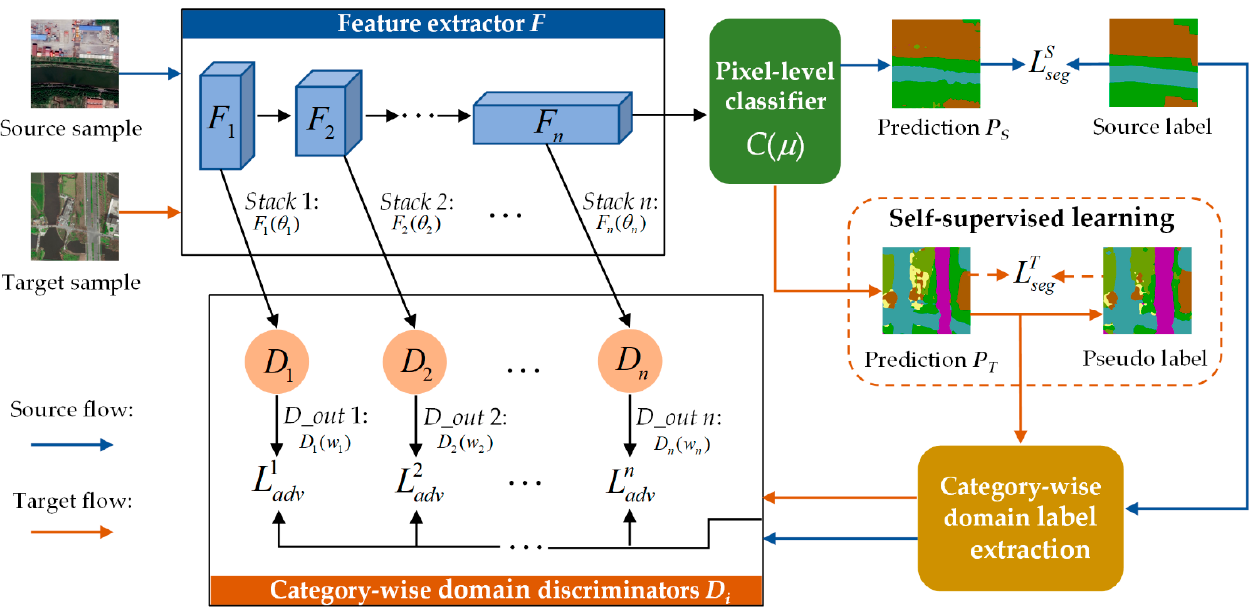
Figure 2. An overview of the proposed category-space constrained adversarial network for cross-domain coastal land cover mapping. The procedure is mainly composed of source flow and target flow that are drawn in different colors.